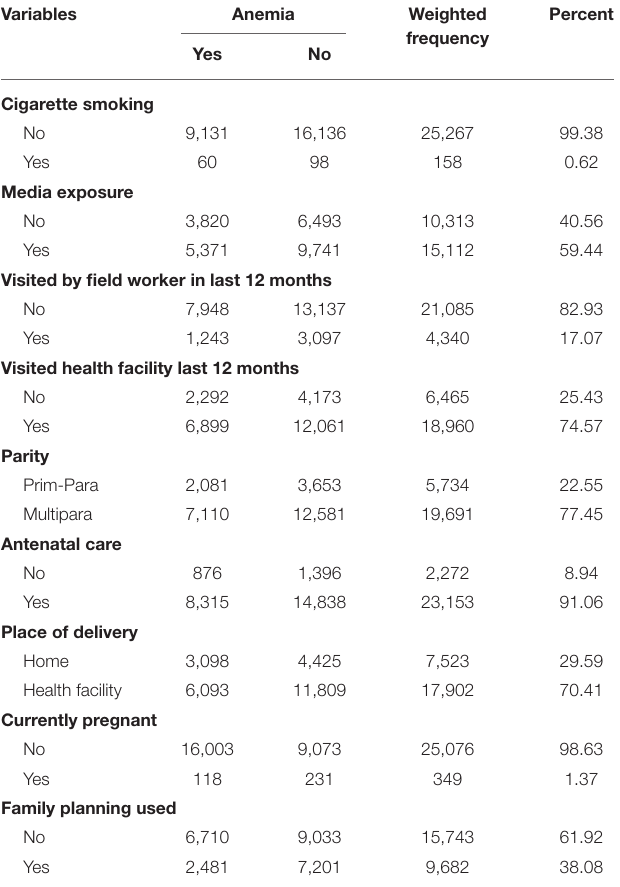
TABLE 3 | Responses on behavioral and obstetric factors for the study on prevalence and associated factors of anemia among lactating mothers in East African countries, 2021.